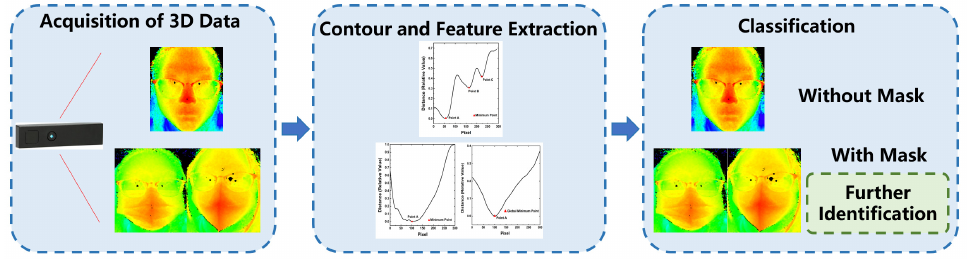
Figure 3. Identification process for whether or not to wear a mask.